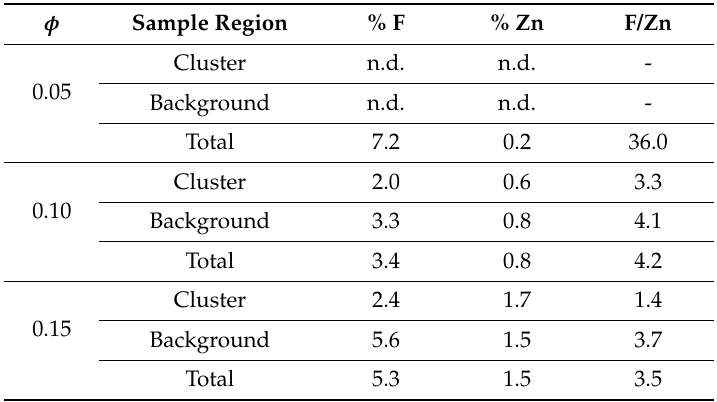
Table 1. energy dispersive X-ray (EDX) elemental analysis, as a function of the metal oxide volume fraction φ . Error is 0.4% in all cases. n.d. = not detectable.